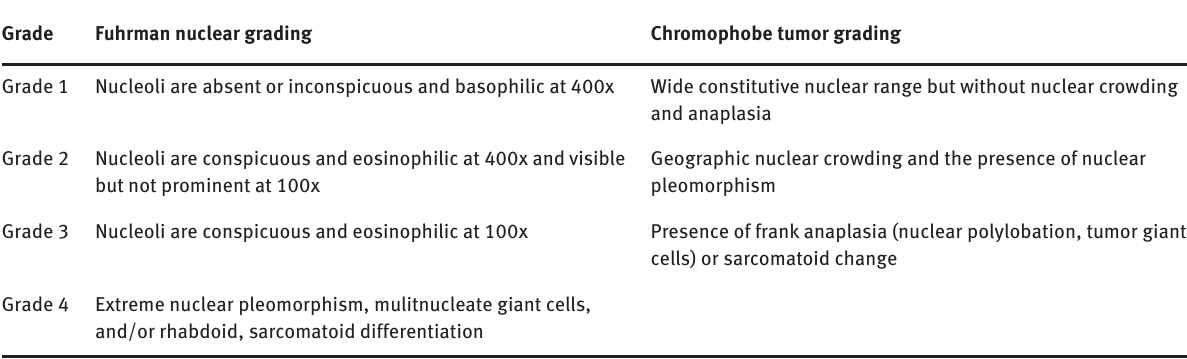
Table 1: The criteria of two tumor grading system for chromophobe RCC